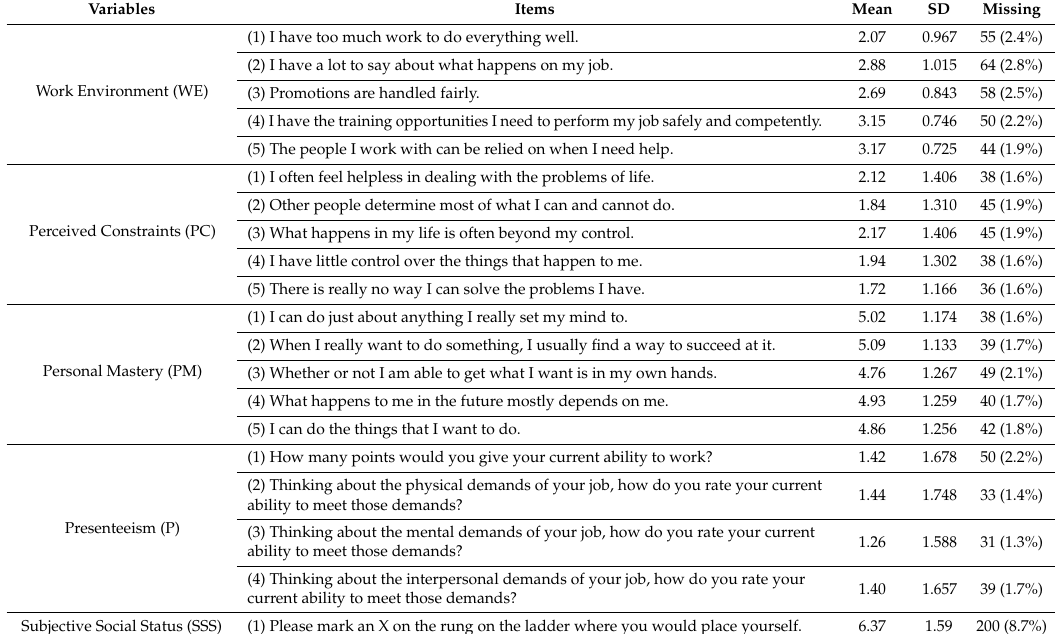
Table 2. Mean, SD, and percentage of missing values for each item.